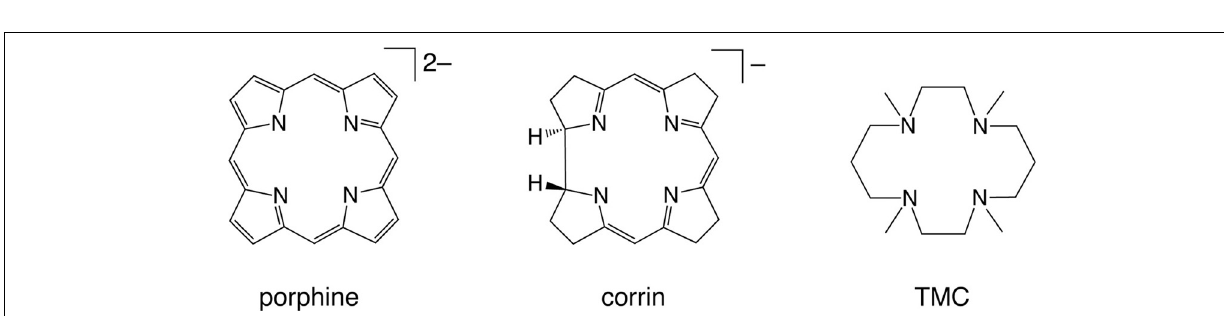
were in good agreement with the available experimental data ( Figure 3A ). The binding affinity was shown to increase in the order Mn 2 + < Cr 2 + ∼ Fe 2 + < Co 2 + < Ni 2 + < Cu 2 + in all lig- ands ( Figure 3B ). The relative binding strength is determined by